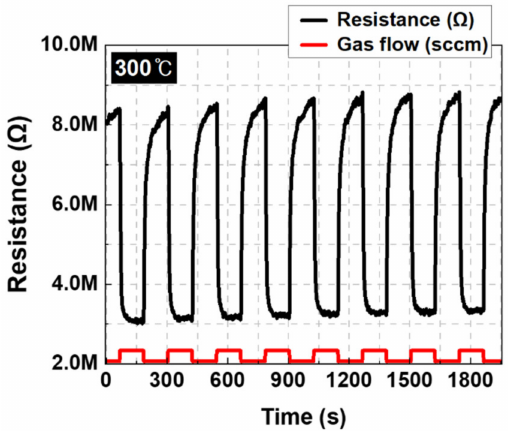
Figure 10. Repeatability tests of 3-h-annealed SnO 2 thin film